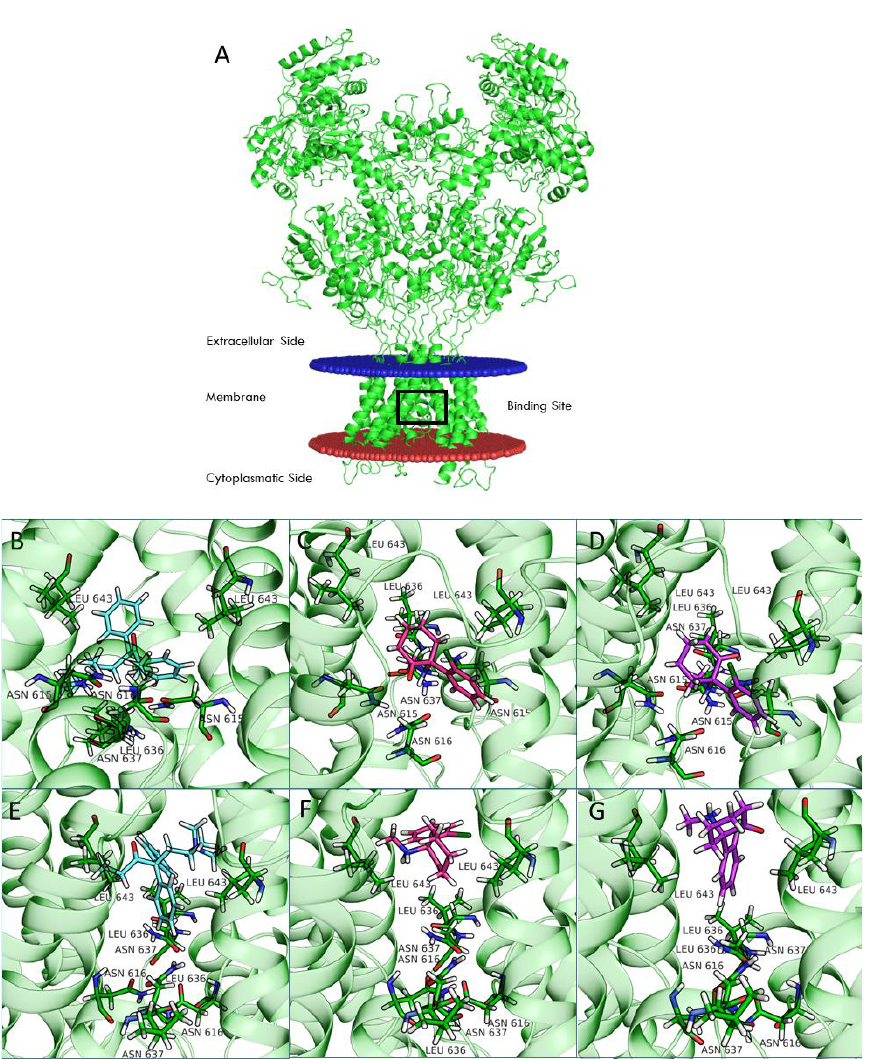
Figure 7. Structure of NR1-2D with drug binding site highlighted by a black box ( A ). The binding of esmethadone ( B , light blue), arketamine ( C , magenta), and esketamine ( D , purple) in open ( B – D , PDB code 6WHT) and closed ( E – G , PDB code 6WHS) conformational states of NR1-2D are shown.